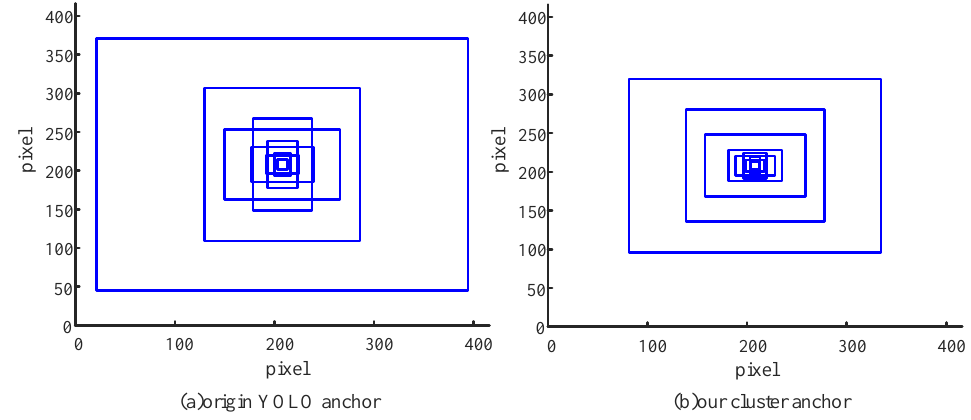
Figure 4. Comparison of anchor before and after clustering.